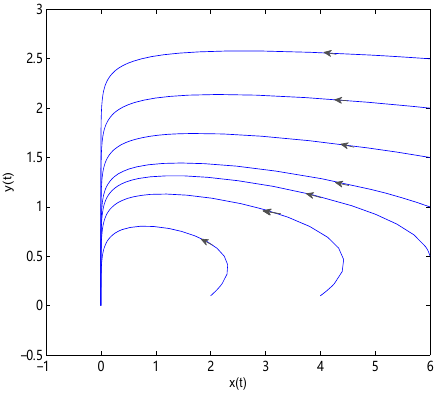
Figure 8. O is globally asymptotically stable. All trajectories tend to O . In here r = 1.5, ω = 3, b = 0.5, c = 1, α = 0.4.